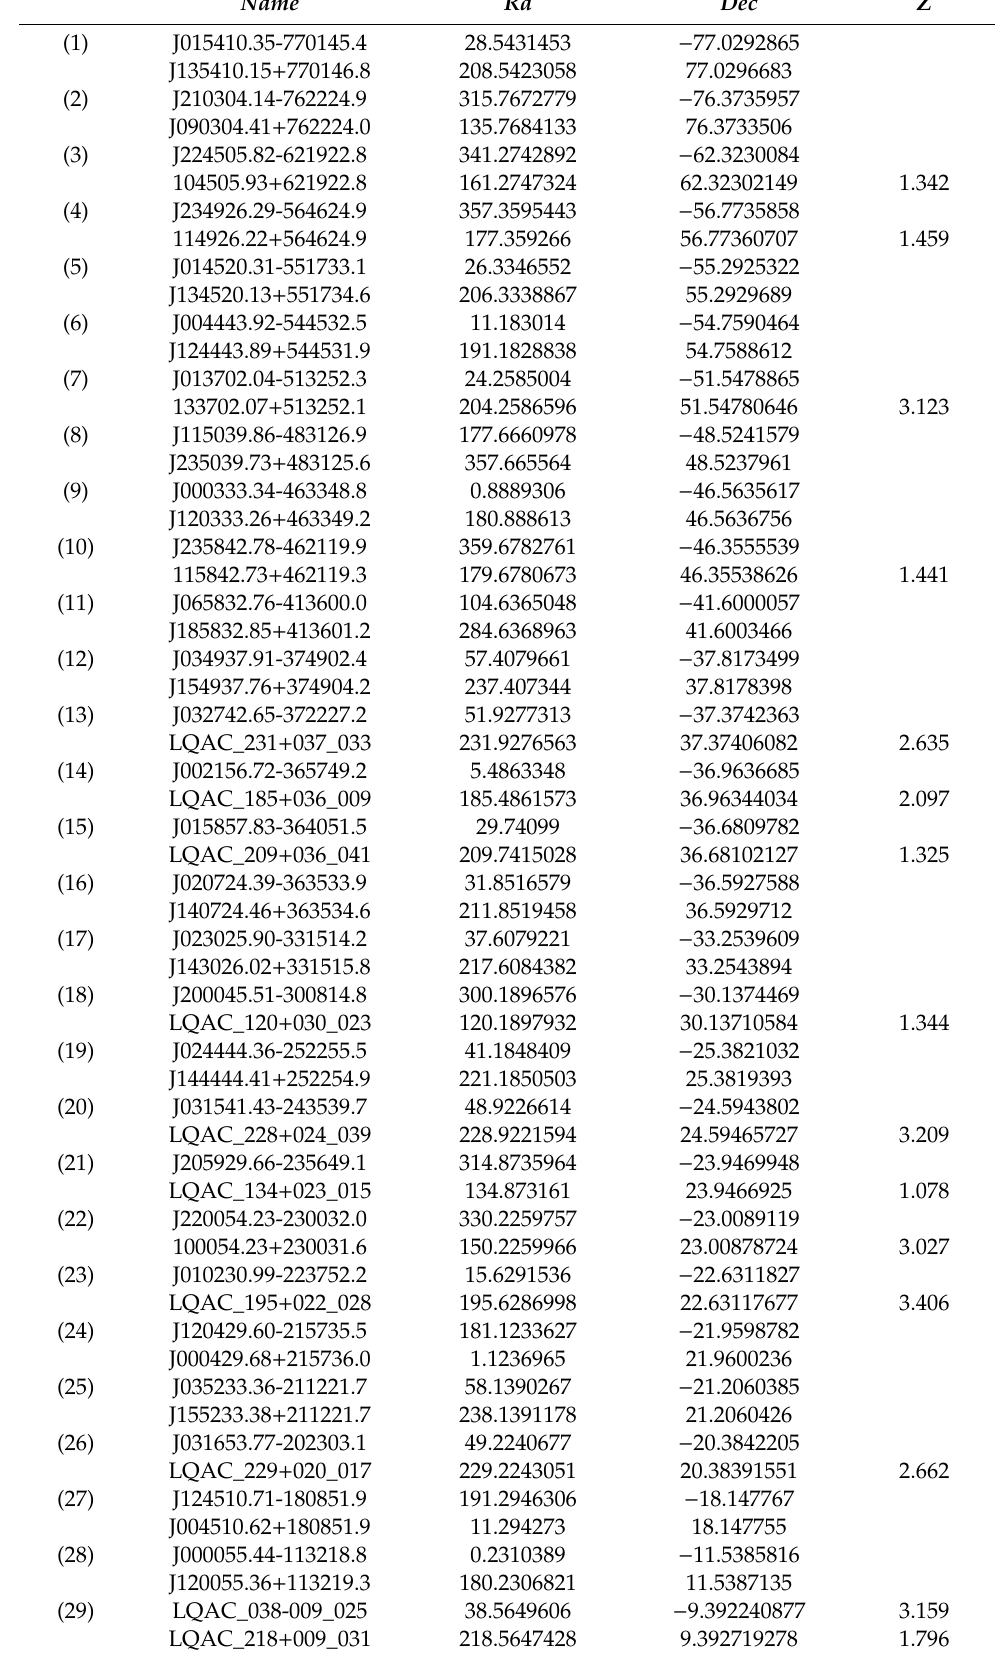
for ra and dec . Redshift z is given when available, although is not essential